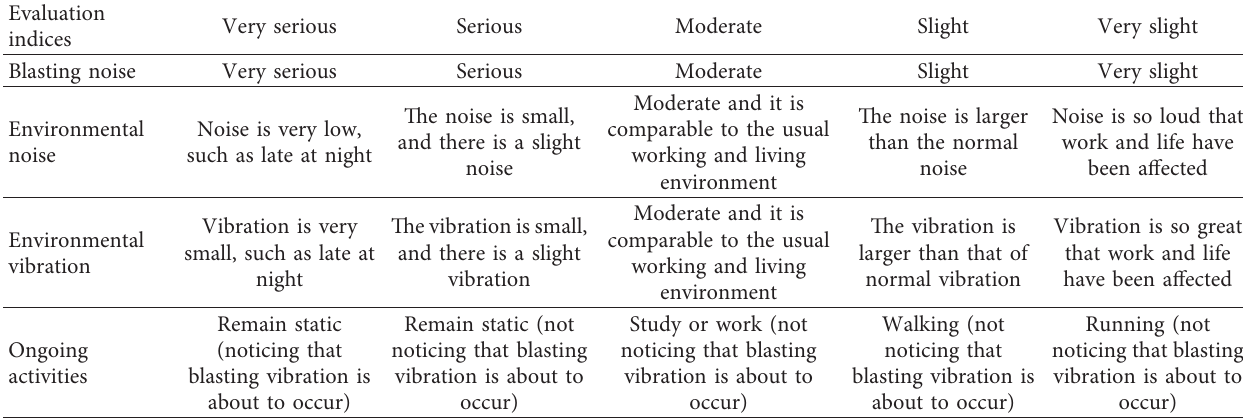
Table 2: The evaluation standard on BVCE indices.